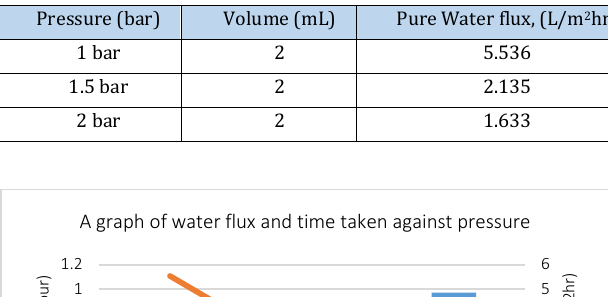
Table 1: The pure water flux based on difference hot pressed pressure